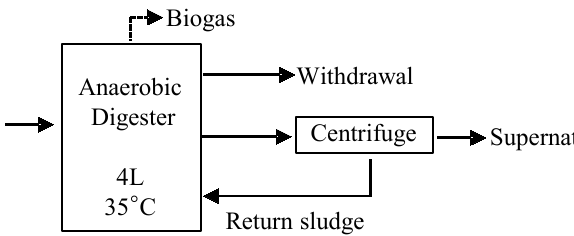
Table 1. Feed substrates and conditions of the two systems.